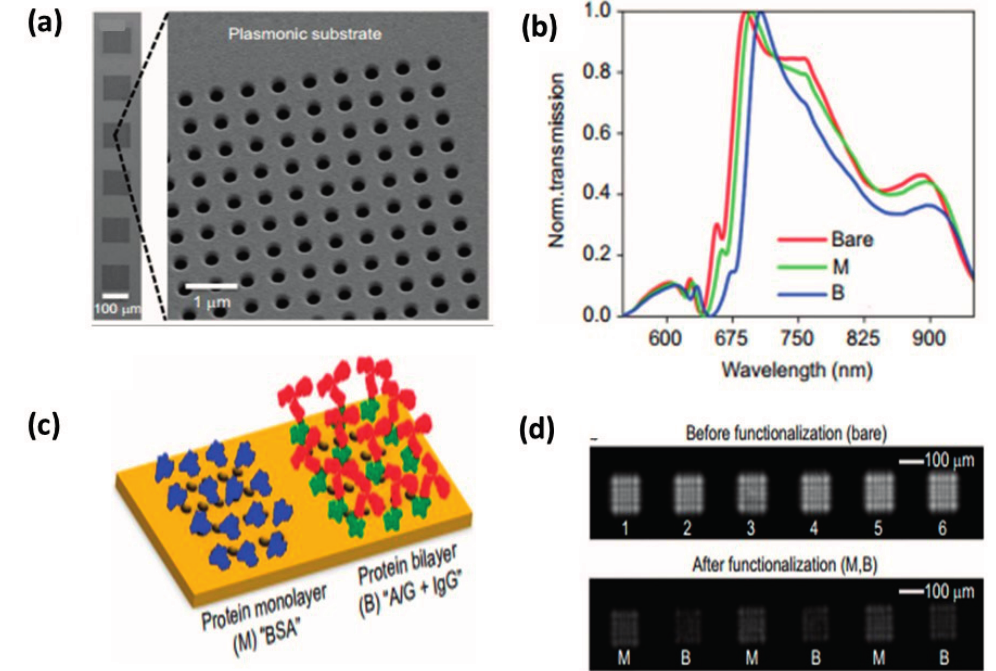
Figure 8. Nanohole substrate for multiplexed biosensing and lens-free imaging. ( a ) SEM images of 6 pixels of nanohole arrays. Each pixel is 100 µm × 100 µm with hole size 200 nm; ( b ) Schematic of nanohole arrays coated with different proteins: Monolayer of BSA (M), bilayer of protein and IgG (B); ( c ) Transmission of bare nanohole arrays (red), with protein monolayer (green) and bilayer (blue); ( d ) diffraction patterns of nanohole arrays before and after functionalization with protein